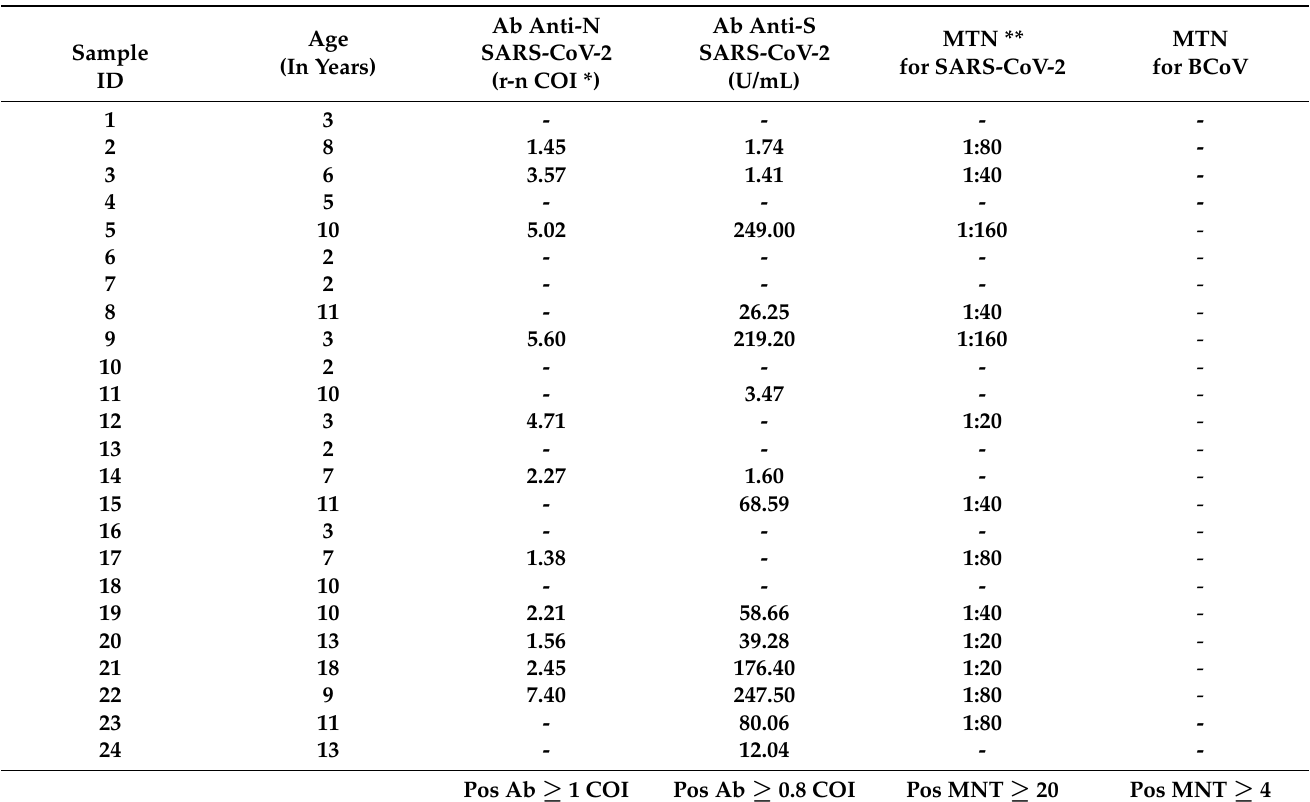
Table 1. Results from serum analyses of sampled